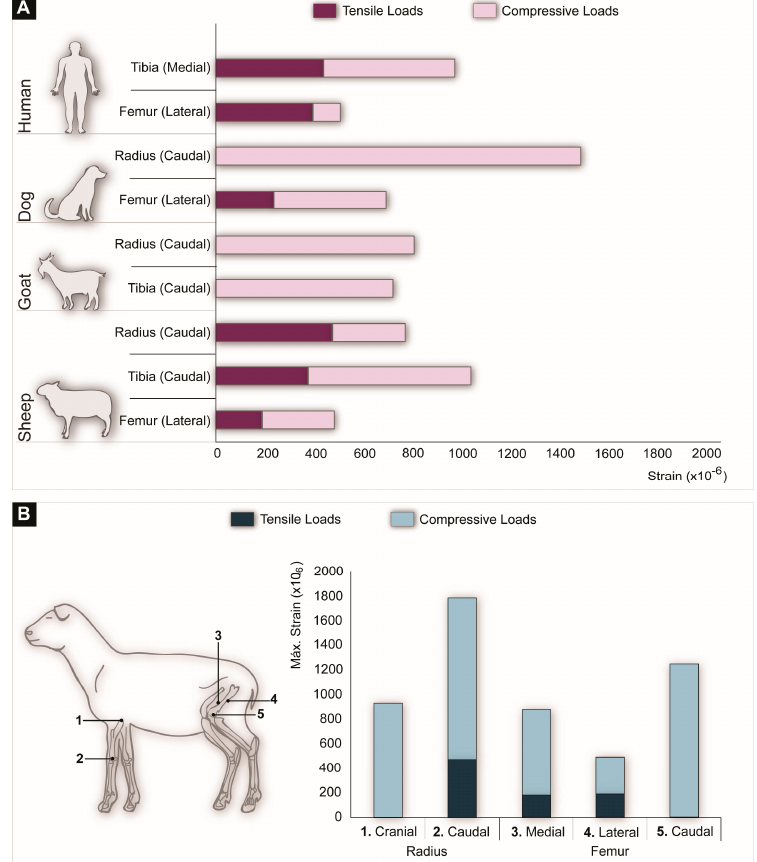
Figure 3. ( A ) Strain values obtained by implanting a strain gauge at different anatomical locations in different animals as compared to humans during walking. ( B ) In vivo strain measurements obtained by strain gauges at different locations on the radius and the femur of a sheep walking at a speed of 1 m/s. The strain gauge detected compression stresses dominating in the cranial aspect of the radius, as well as the caudal aspect of the femur. In contrast, the caudal aspect of the radius and the medial and lateral aspects of the femur were subjected to both compressive and tensile stress (the data used for this figure were compiled from [19,21,110 – 116]). Limb bones . Segmental bone defects . Clinically, segmental bone defects have a non-union rate as high as 21% [117] and originate from trauma or resection of necrotic and/or infected bone. In humans, the most commonly used anatomic region affected by segmental bone defects is the tibial shaft [98]. Critically sized segmental defects may include an entire segment of bone (Figure 4A) or just the cortical component (Figure 4B). Limb bones are highly loaded, not only due to weight support (i.e., in the case of lower limbs), but also because these structures are constantly subjected to tensile stresses that originate from the action of muscles, tendons or ligaments.